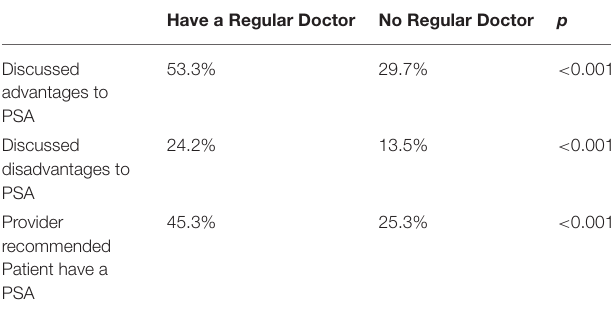
TABLE 1 | Characteristics of men who did and did not receive PSA screening. TABLE 2 | Discussion of PSA screening by continuity of